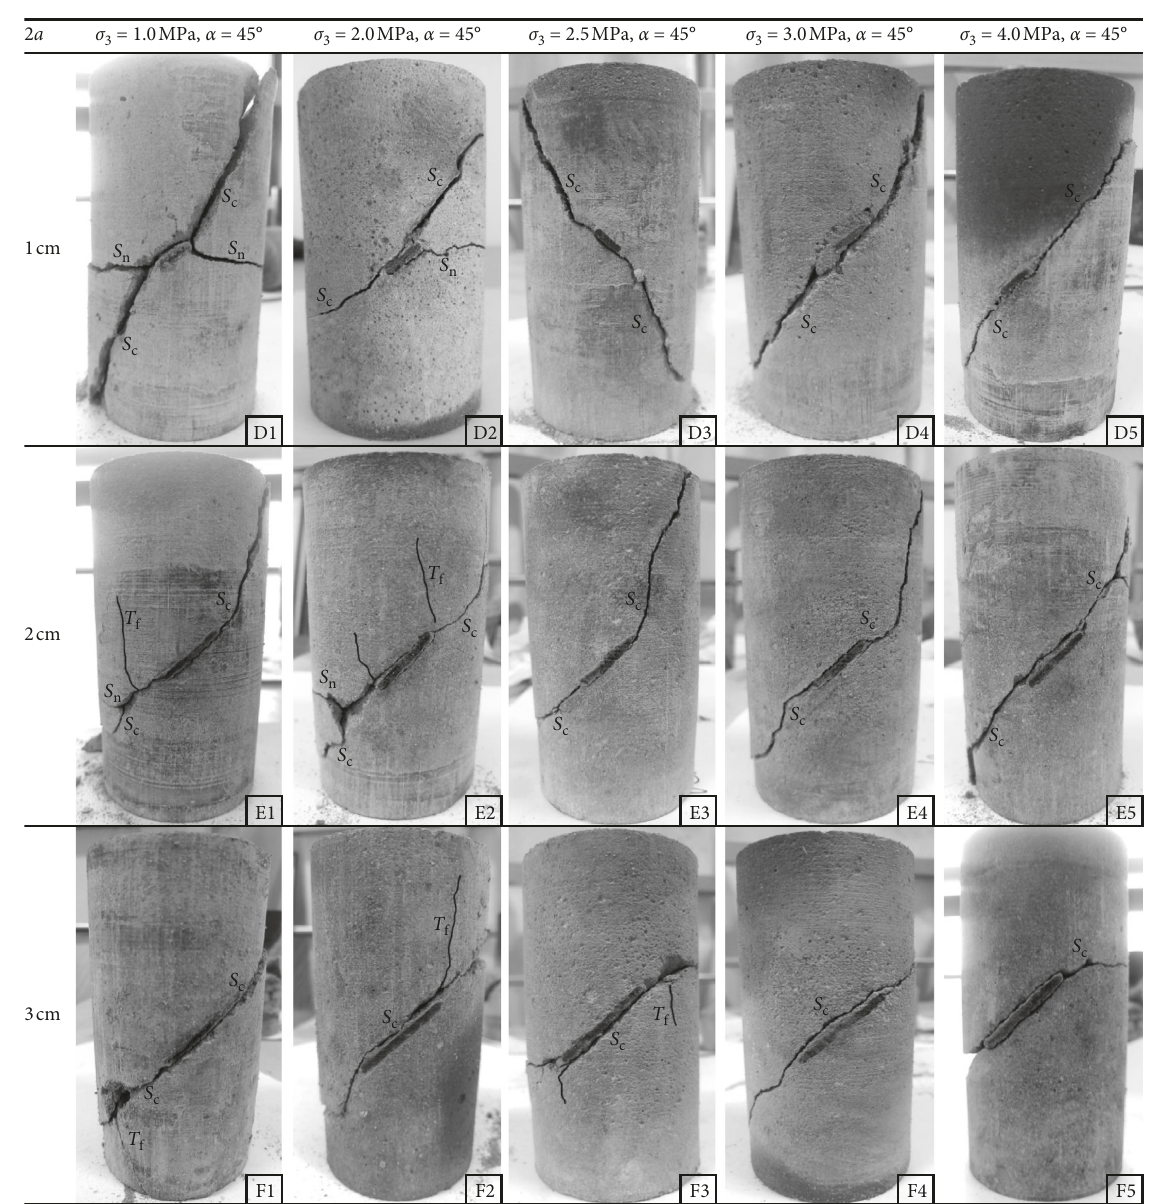
Figure 6: Failure modes of the specimens with a grout-infilled flaw having an inclination angle of 45 ° and different flaw